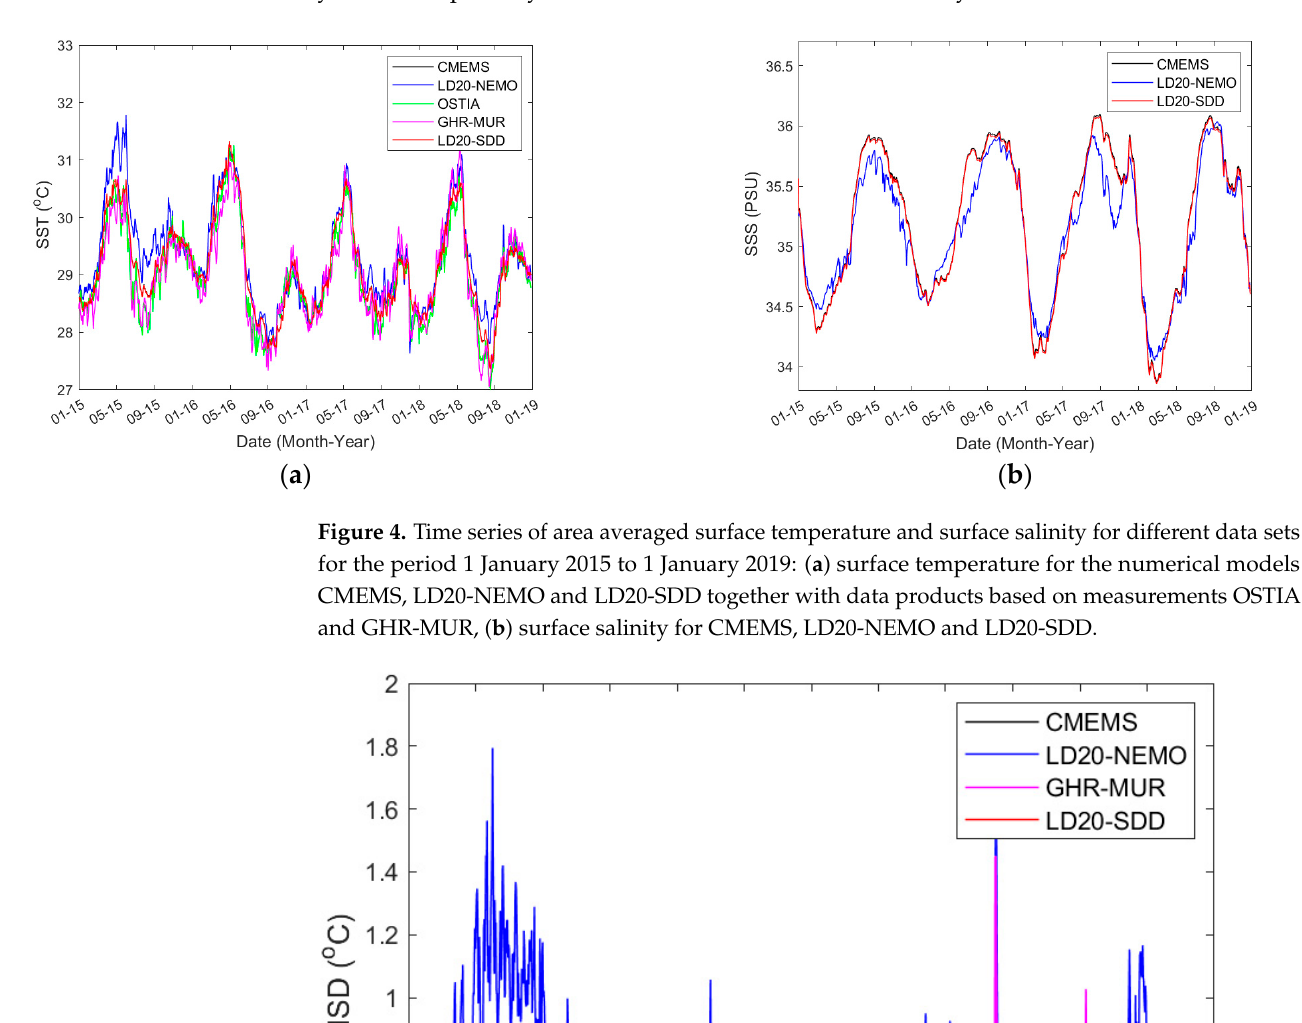
‘Variational Bias control for satellite radiances’ [35]. Therefore, Table 1 below shows the year 2015 separately, as well as in combination with other years.